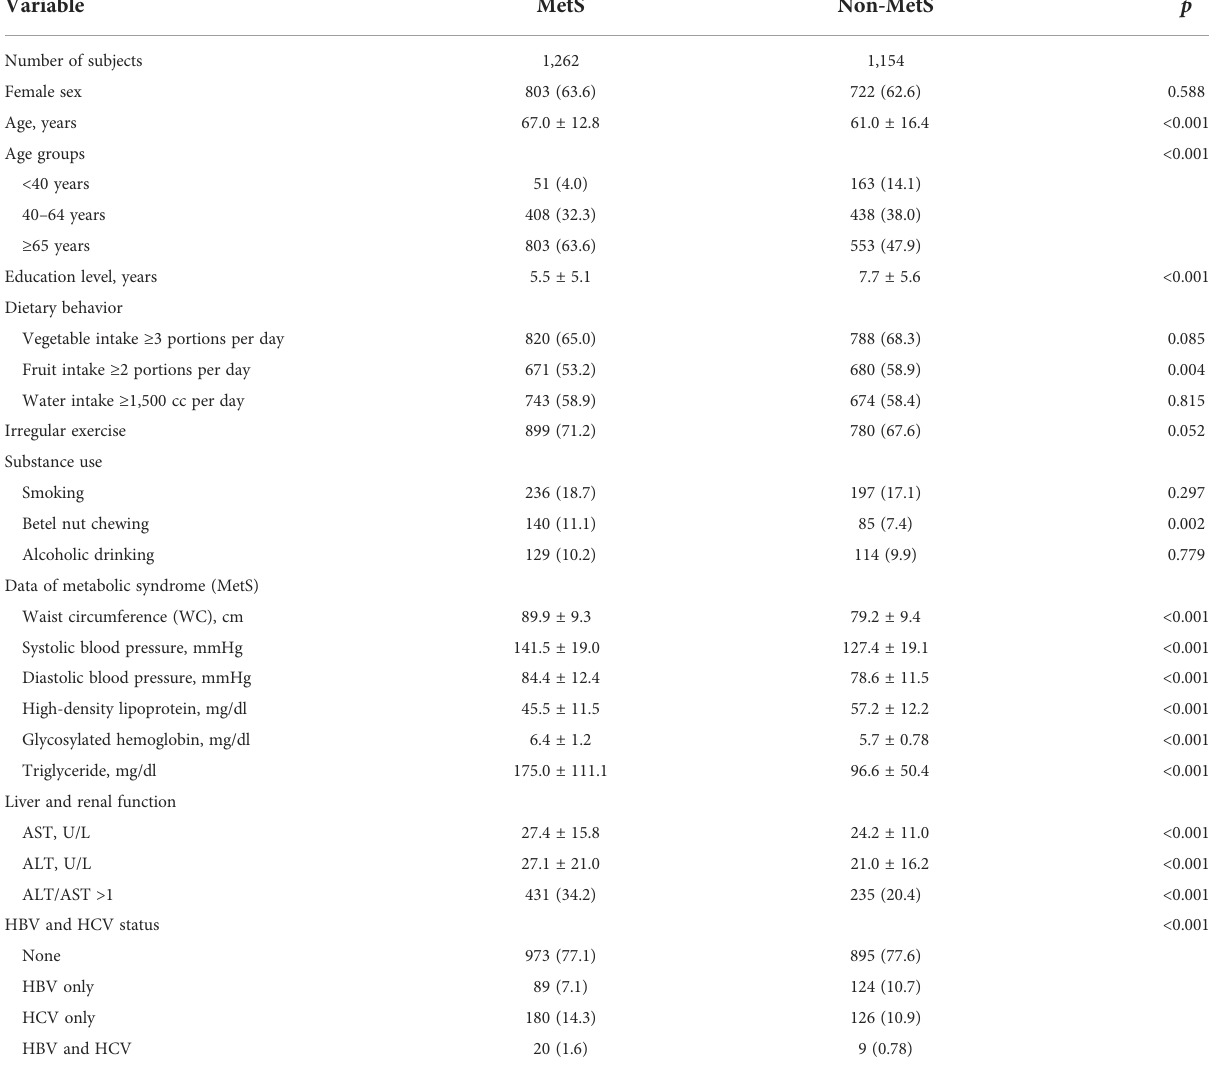
TABLE 2 Demographics and characteristics of the study subjects according to the status of MetS ( N =